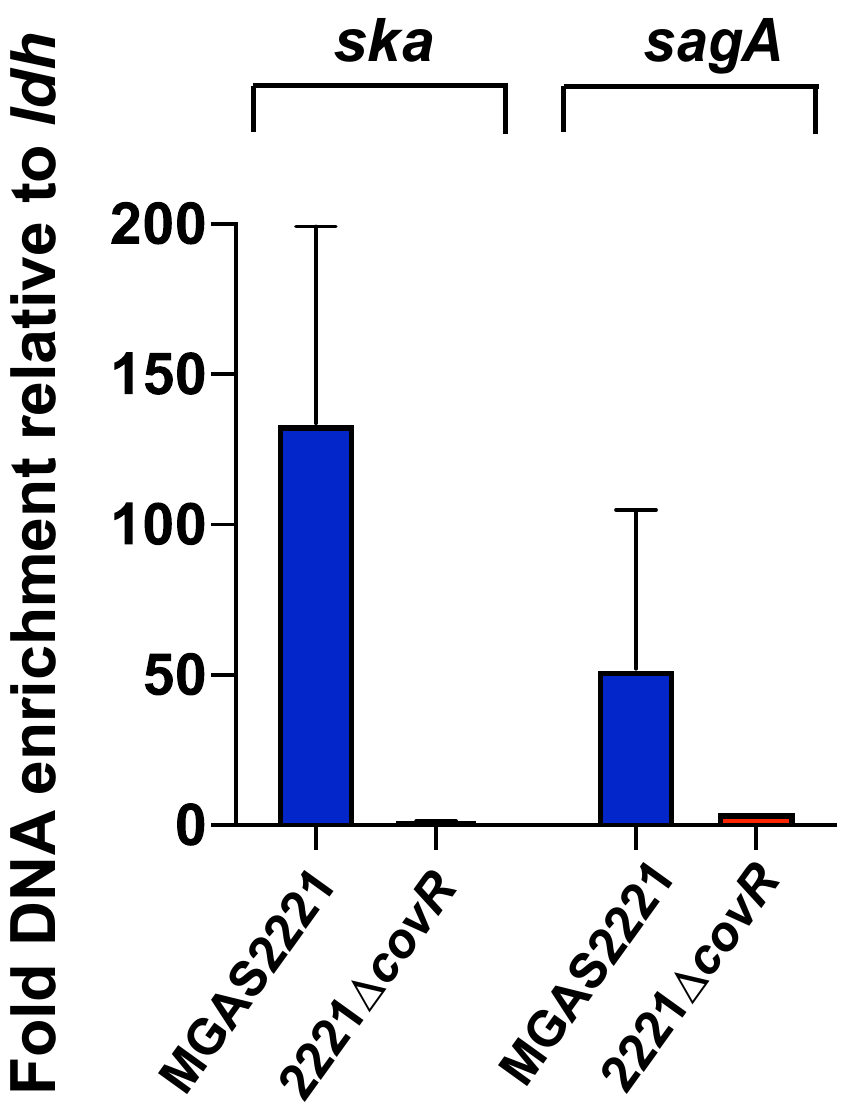
Fig 1. ChIP using anti-CovR antibody enriches ska and sagA promoter DNA. SYBR qPCR analysis to quantify enrichment of ska and sagA promoter DNA in ChIP samples obtained from GAS strains MGAS2221 and 2221 Δ covR using anti-CovR ND antibody. Values were normalized to fold-enrichment of the ldh promoter, a gene whose expression is not affected by CovR. Measurements were done in duplicate with four biological replicates grown in THY to mid-exponential phase. Data graphed are mean ± standard